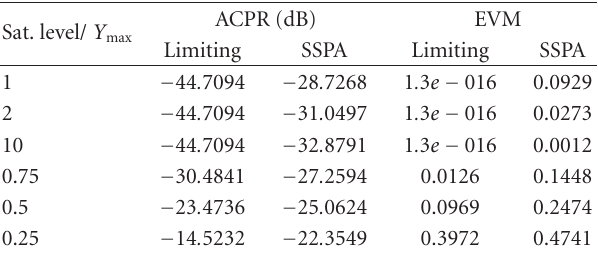
Figure 10: BER of OFDM system with HPA. Table 1: ACPR and EVM for di ff erent limiting values.